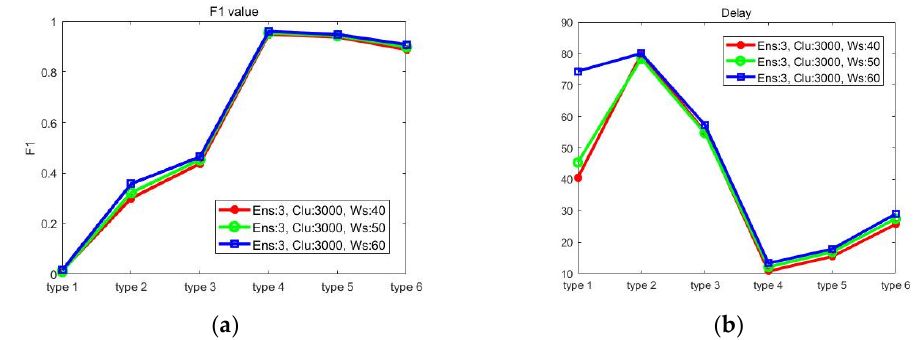
Figure 2. The performance comparison when the number of ensemble members is 1 or 3. The number of clusters and the window size were fixed to 3000 and 50. ( a ) Comparison of F1 value ( b ) Comparison of Delay.